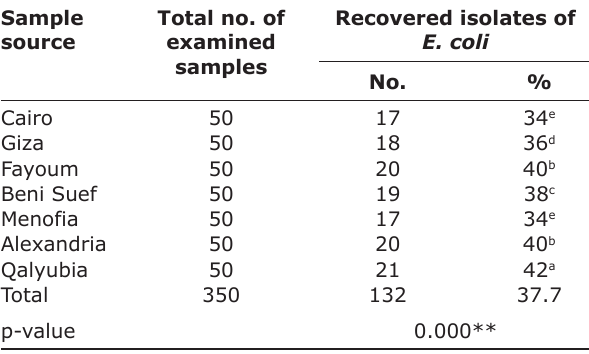
Table-4: Prevalence rates of E. coli isolates from poultry samples.